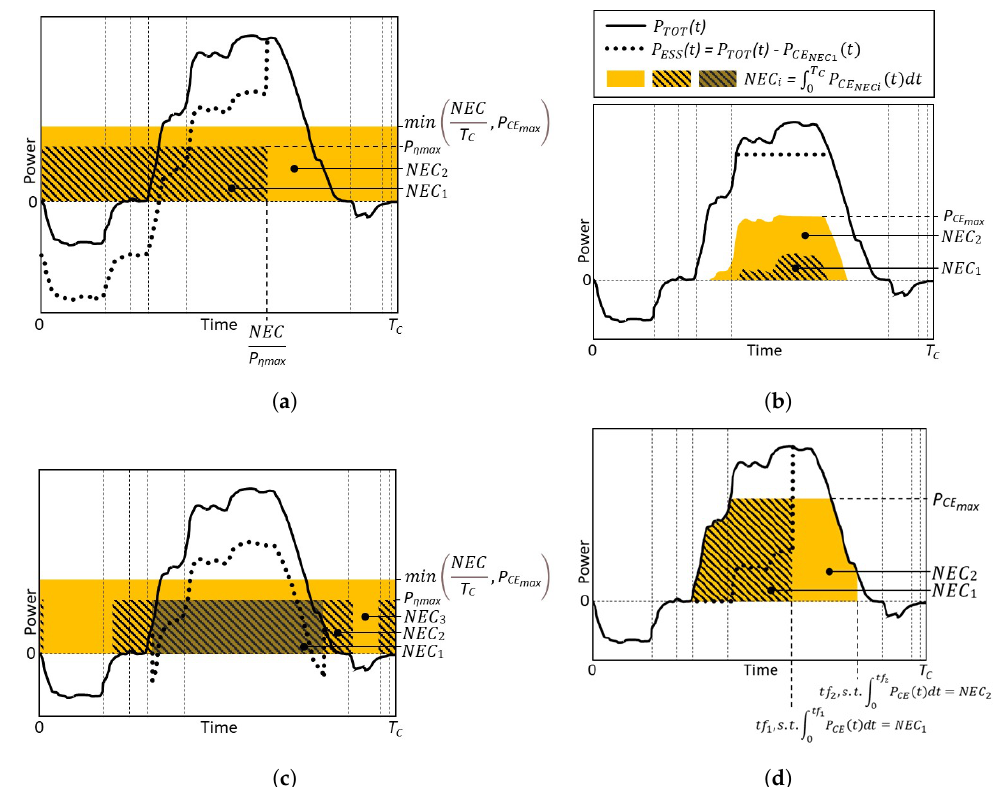
Figure 7. Visual representation of the GS control algorithms presented in Table 8. The trajecto- ries and shaded areas are to be interpreted as follows: solid line = P TOT ( t ) ; dotted line = P ESS ( t ) = P ( t ) − P ( t ) ; shaded and dashed areas = NECi = (cid:82) T C TOT CE NEC 1